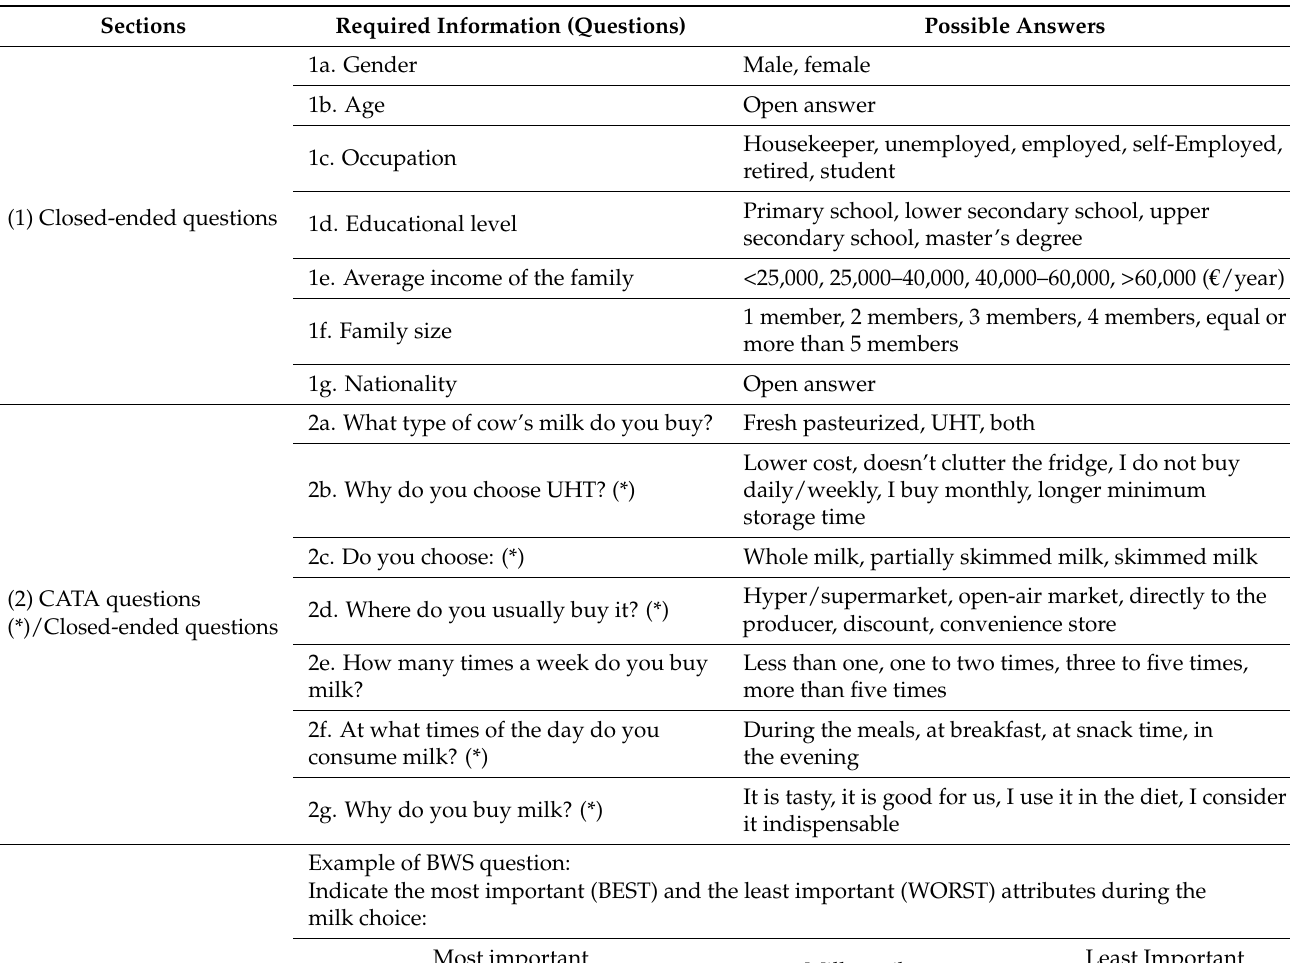
Table 1. Questionnaire